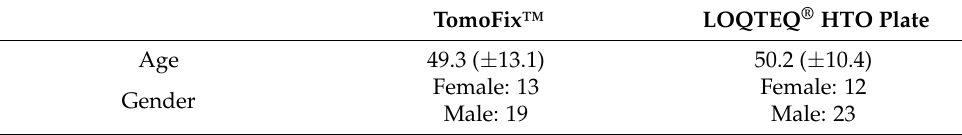
Table 2. Age and gender distribution.